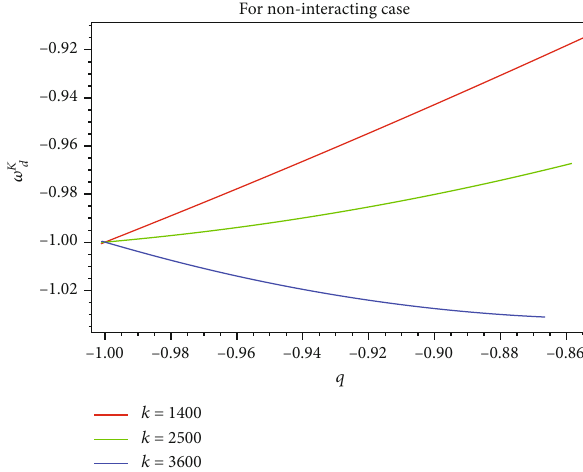
Figure 4: Variation of EoS parameter ω K parameter q .